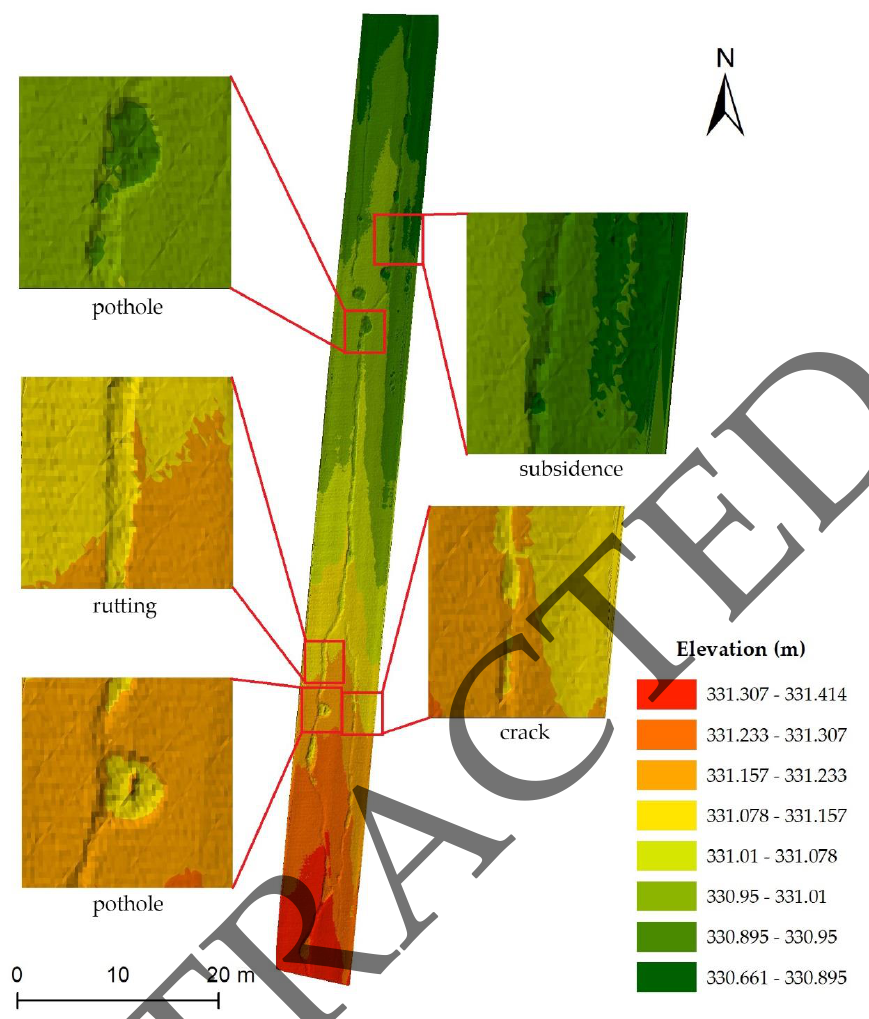
Figure 6. Triangulated irregular network (TIN) model of the road section in the study area.